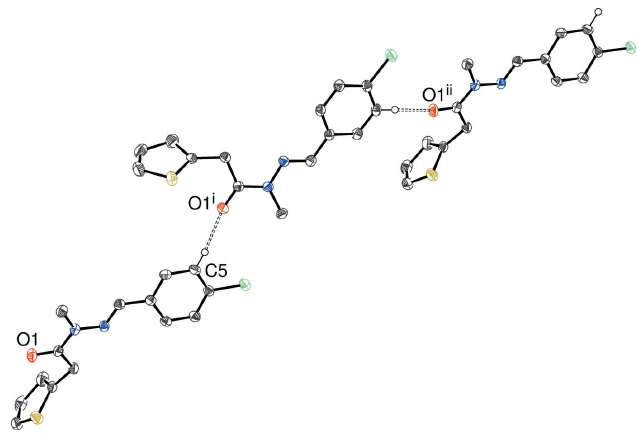
Figure 7 Fragment of a [301] hydrogen-bonded chain in the crystal of (IV).